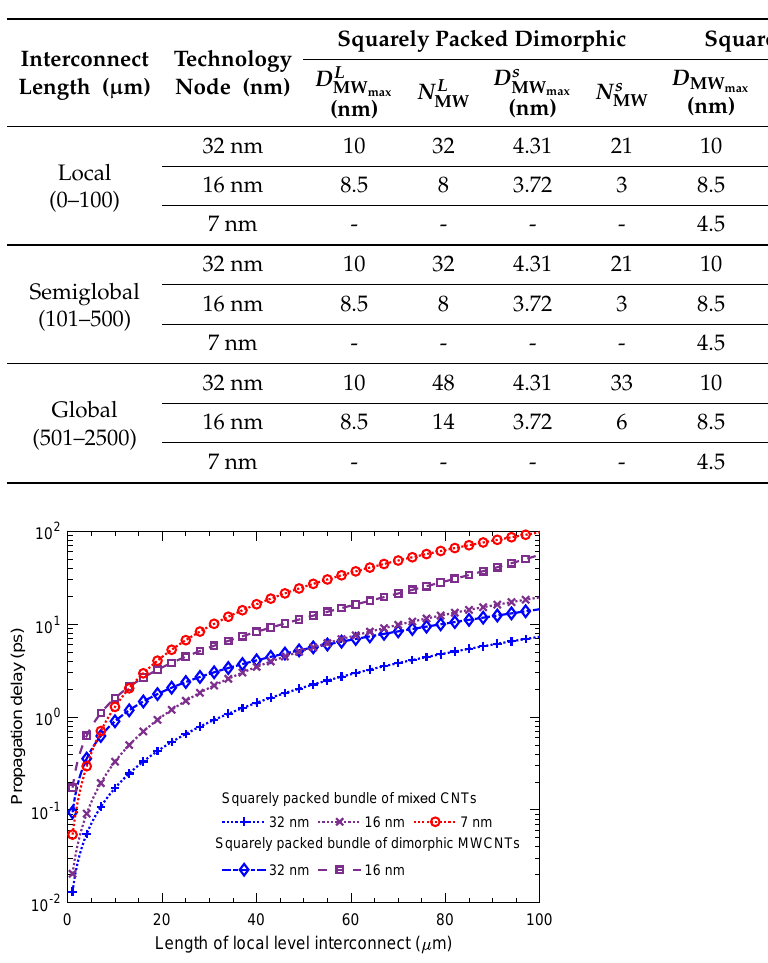
Table 1. Diameter and number of pertinent CNTs accommodated in the bundle during simulation to obtain propagation delay and crosstalk delay.